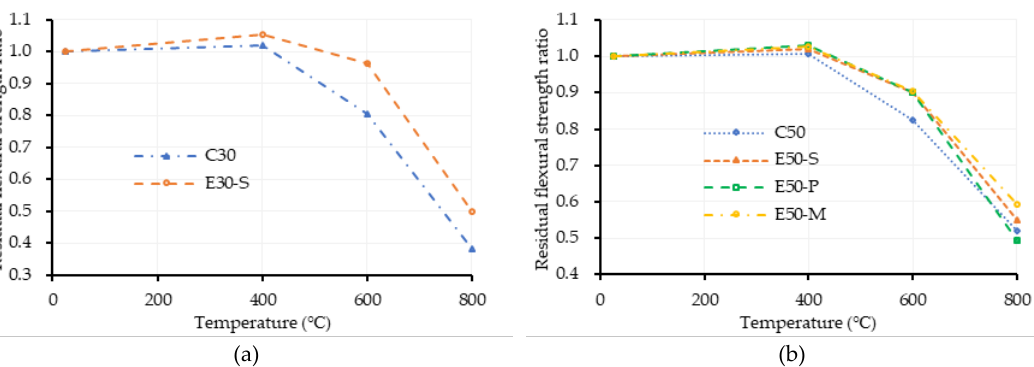
Figure 11. Comparison of residual flexural strength ratio of LWC specimens: ( a ) low-strength concrete and ( b ) medium-strength concrete.